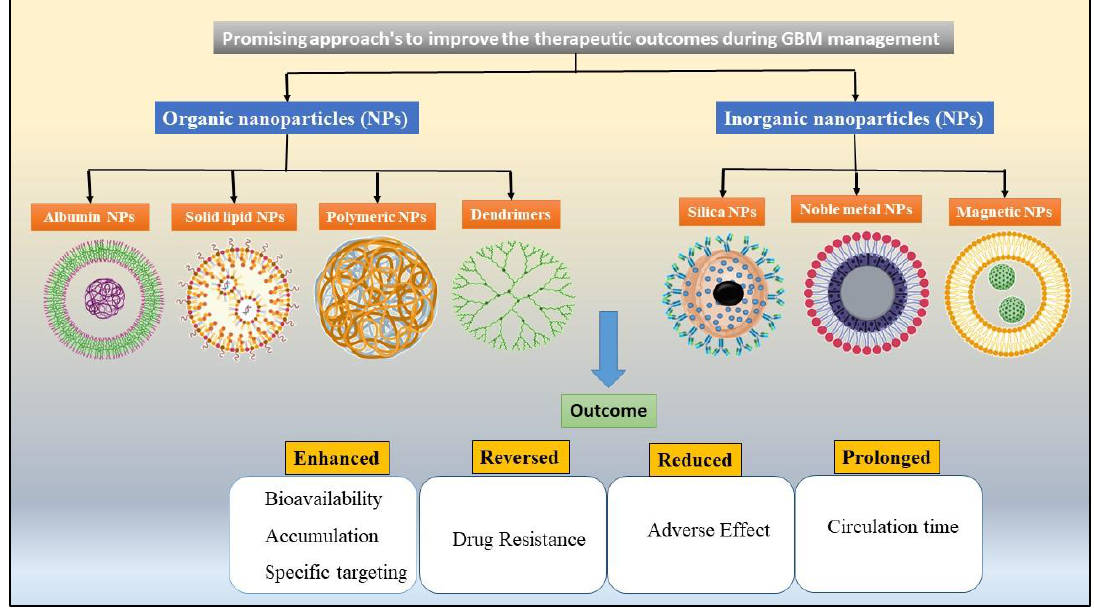
Figure 3. Different nanodelivery systems that facilitate BBB penetration and target-specific action in glioma.